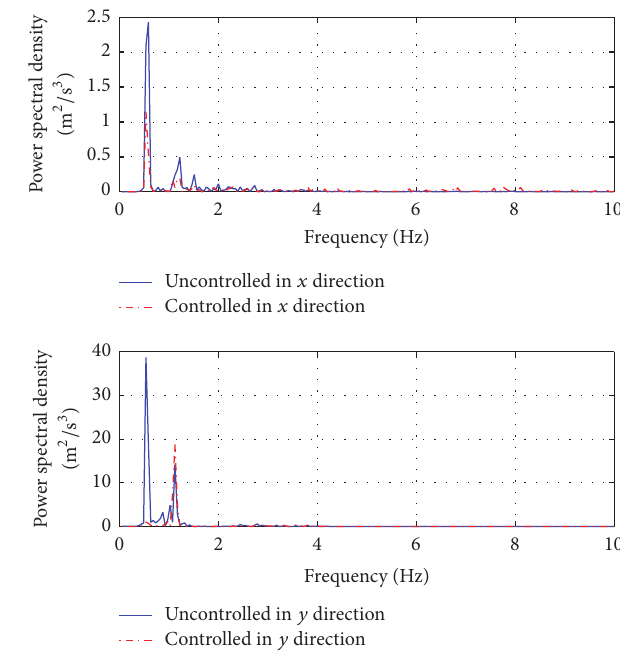
Figure 16: Acceleration power spectral density of the tower turret.